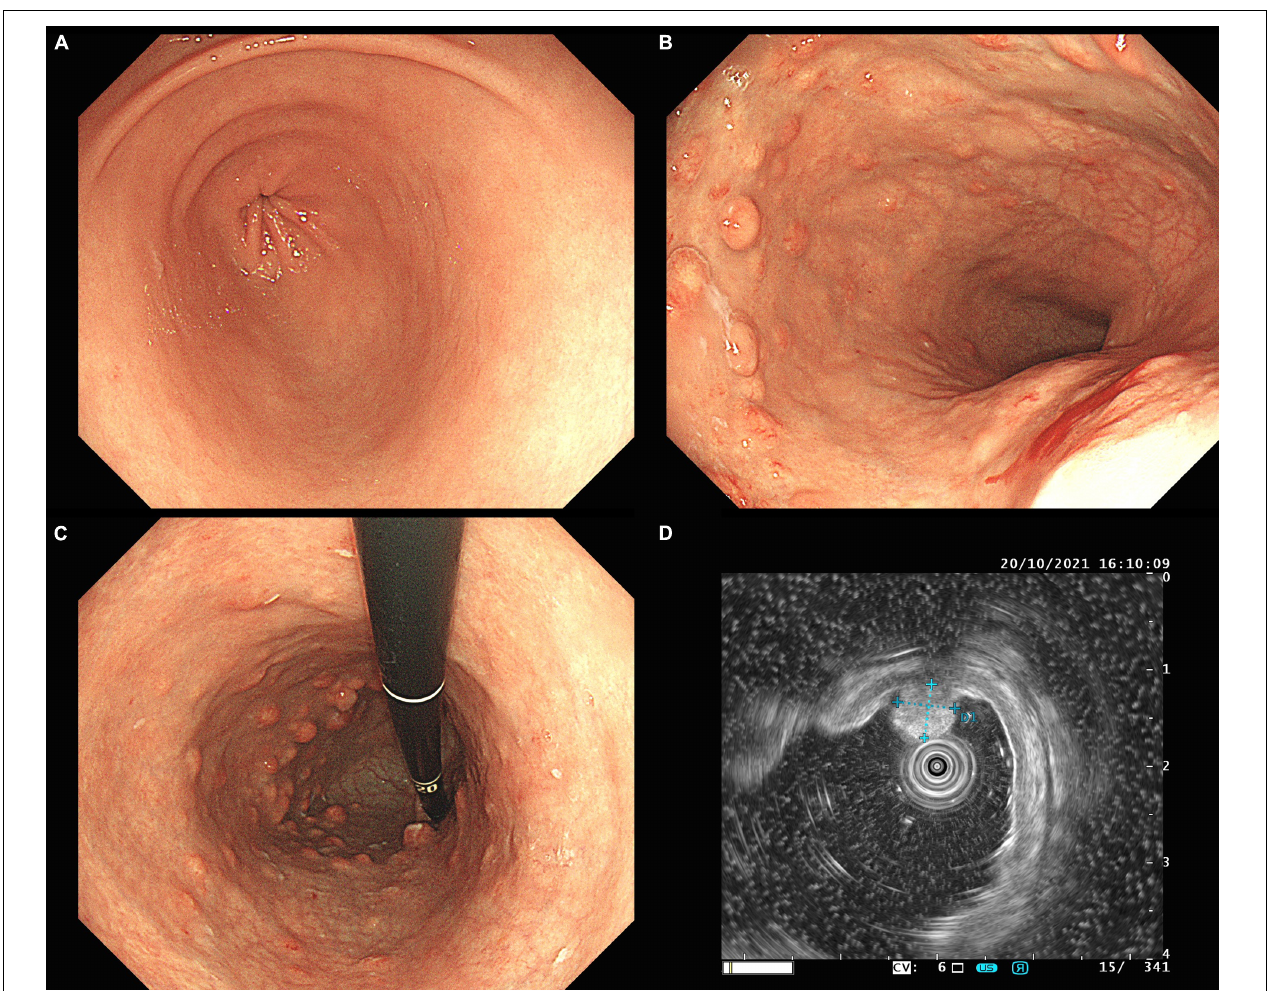
FIGURE 1 | Routine gastroscopy revealed smooth mucosa in the gastric antrum (A) , absence of gastric fold along the greater curvature of the gastric body (B) , pale appearance of mucosa, increased visibility of vasculature, and multiple gastric submucosal bulges within gastric body, and fundus (B,C) , EUS confirmed hyperechoic NETs originated from the muscularis mucosa, with an intact muscularis propria (D)